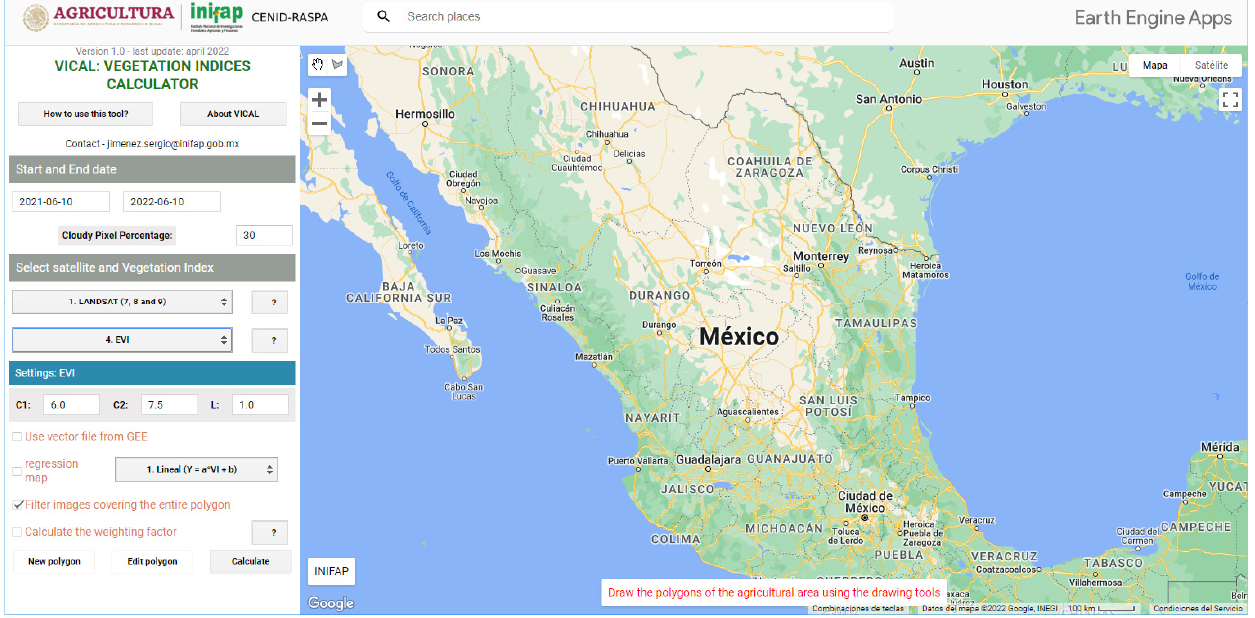
Figure 4. Main menu of the VICAL